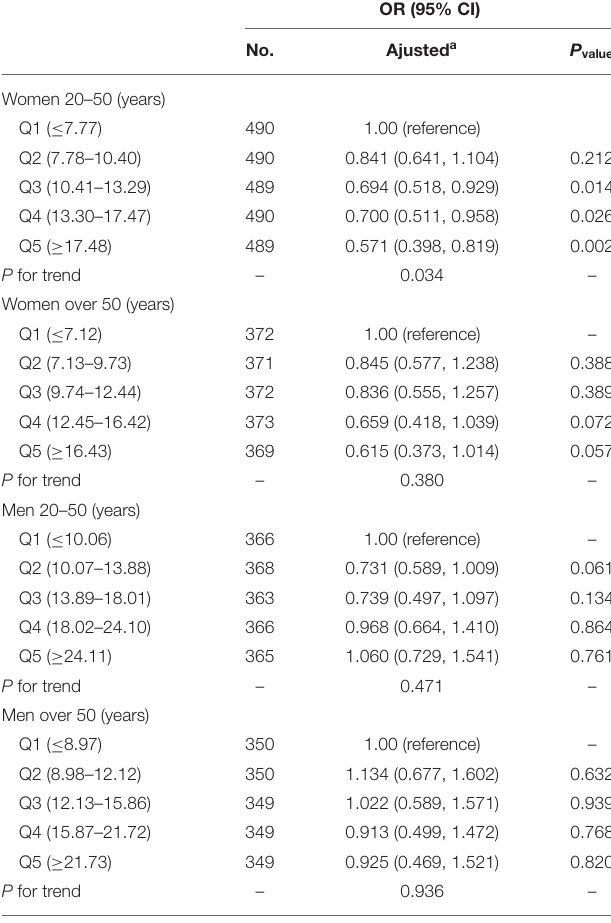
TABLE 4 | Effect of dietary iron on headache in different sex and age